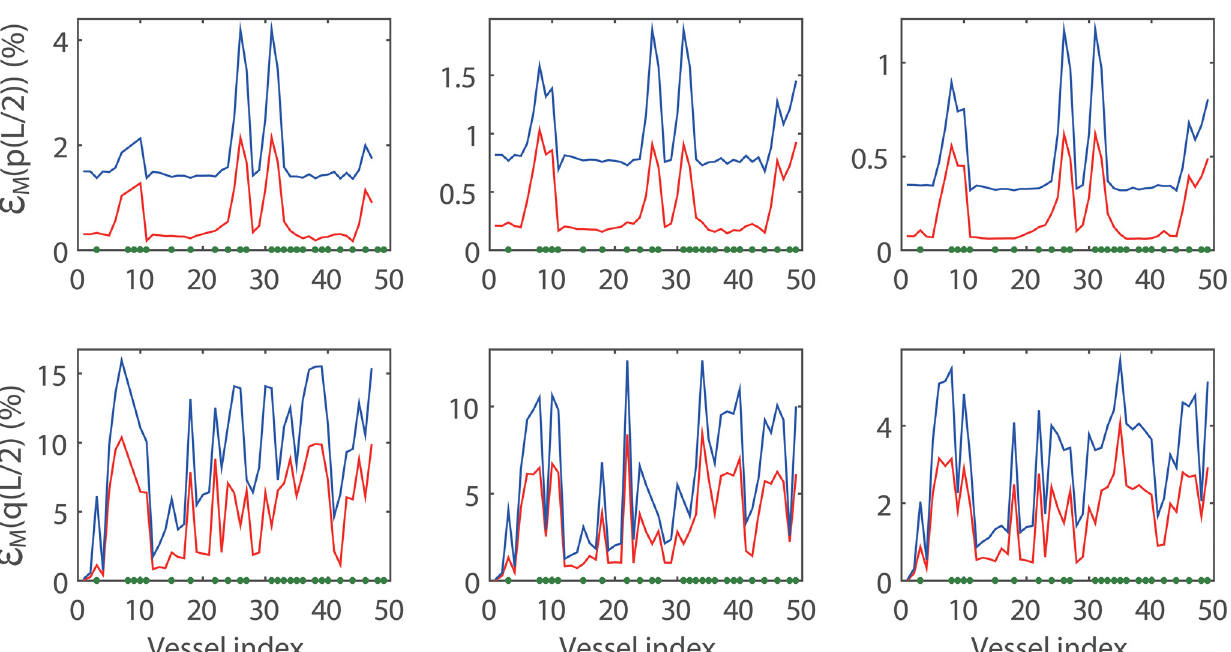
Fig 7. Modeling error induced by the CWK model and the WK model in three systemic arterial trees. The red and blue lines represent the modeling errors induced by the CWK model and the WK model, respectively. The x -axis is the vessel index in Table 2. There is a total of 83, 149, and 335 vessels in the three arterial trees with R t = 0.25 cm (left panel), R t = 0.20 cm (middle panel), and R t = 0.15 cm (right panel), respectively. The terminal vessels of the original arterial tree shown in Fig 1B and 1C are labeled by the green dots on the x -axis.